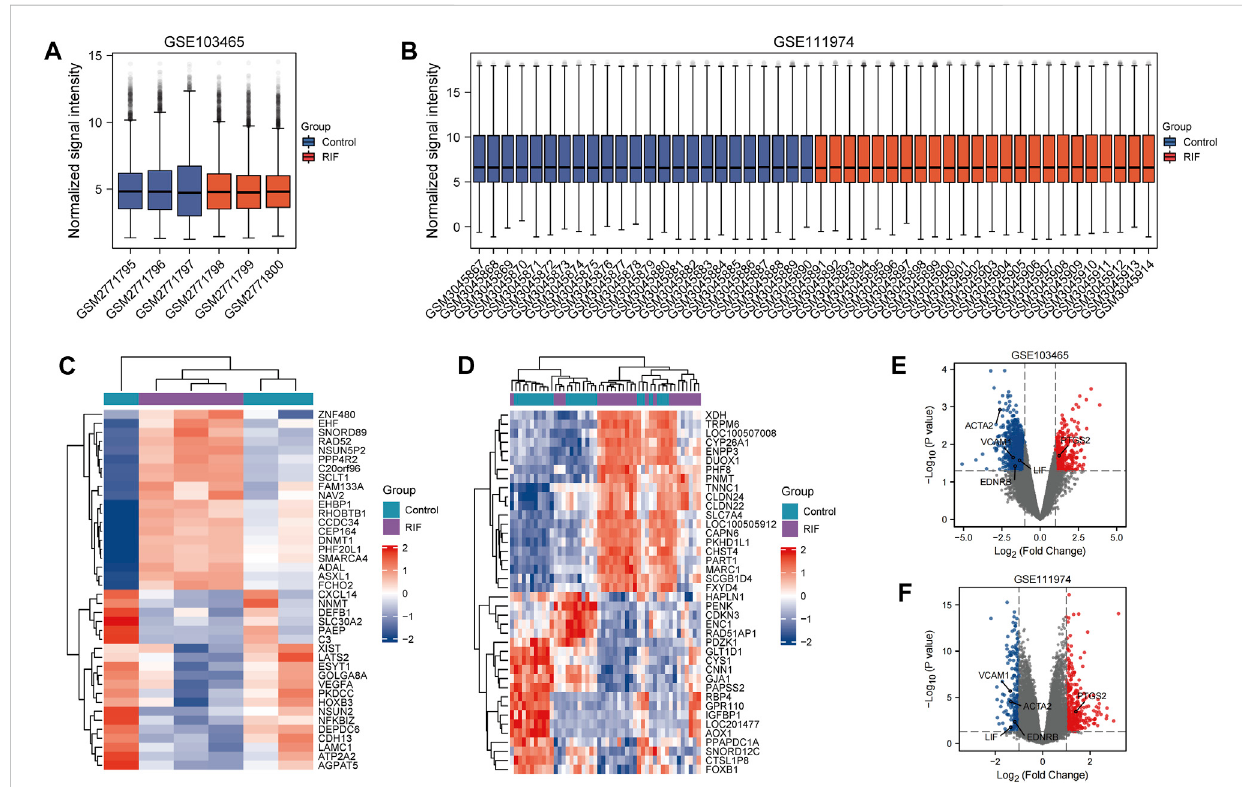
FIGURE 2 Box plots, Heatmaps and Volcano plots of DEGs between RIF and control group. (A, B) Box plotsof GSE103465 (A) and GSE111974 (B) . Red refers to RIF group, while blue represents control group. (C, D) Heatmaps of 10 DEGs who have the highest log FC and 10 DEGs with the lowest log FC from GSE103465 (C) and GSE11194 (D) . Red refers to the elevated genes, and blue directs to the downregulated genes. (E, F) Volcano plots of DEGs in GSE103465 (E) and GSE111974 (F) . Red refers to the increased DEGs, and blue points to the reduced